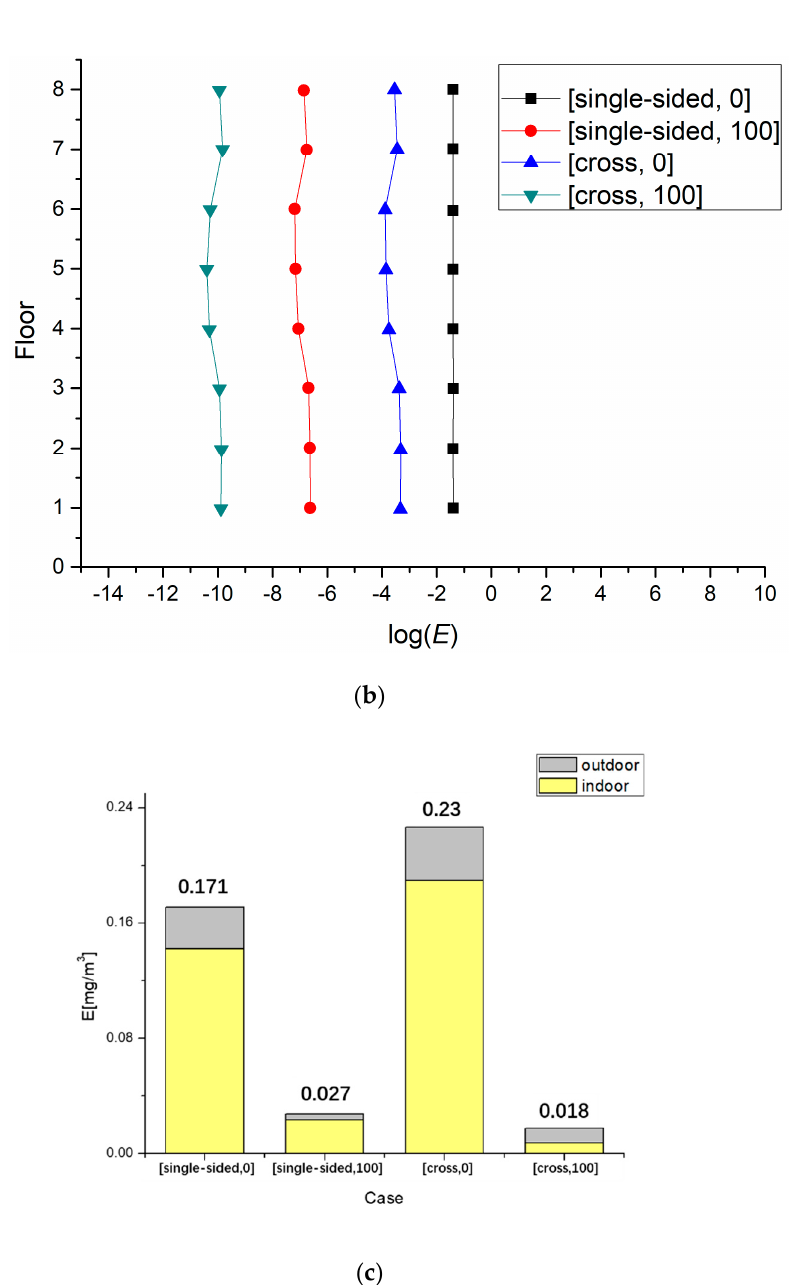
Figure 9. Mean exposure concentration ( E ) at eight floors in the leeward building side ( a ) and windward building side ( b ) in the target street canyon; ( c ) is the mean E for the total population in four cases.